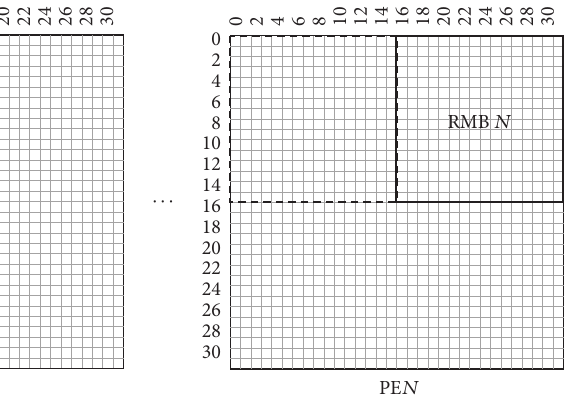
Figure 6: Location of RMBs in search